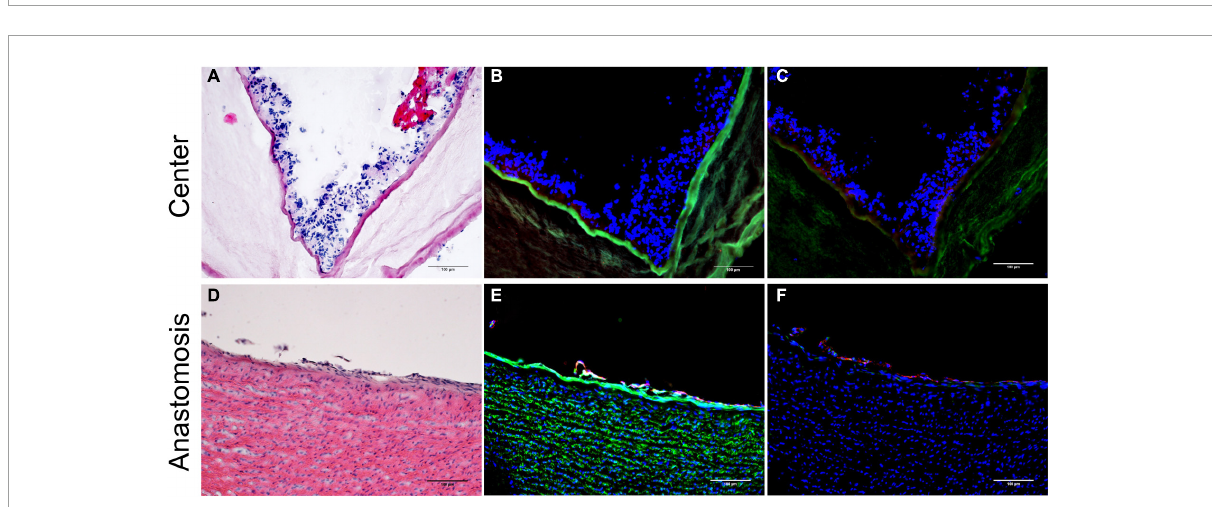
FIGURE5 Inner layer of the vascular grafts 4 weeks after implantation. Representative images of the vascular grafts at the central part (A–C) and at the anastomosis site (D–F) stained with H&E (A,D) and immunofluorescence antibodies specific for Ve-Cadherin (red), α -SMA (cyan), laminin (green) (B,E) , and for CD31 (red) and CD68 (green) (C,F) . Nuclei were stained with DAPI (blue) (B,C,E,F) . Scale bar = 100 µ